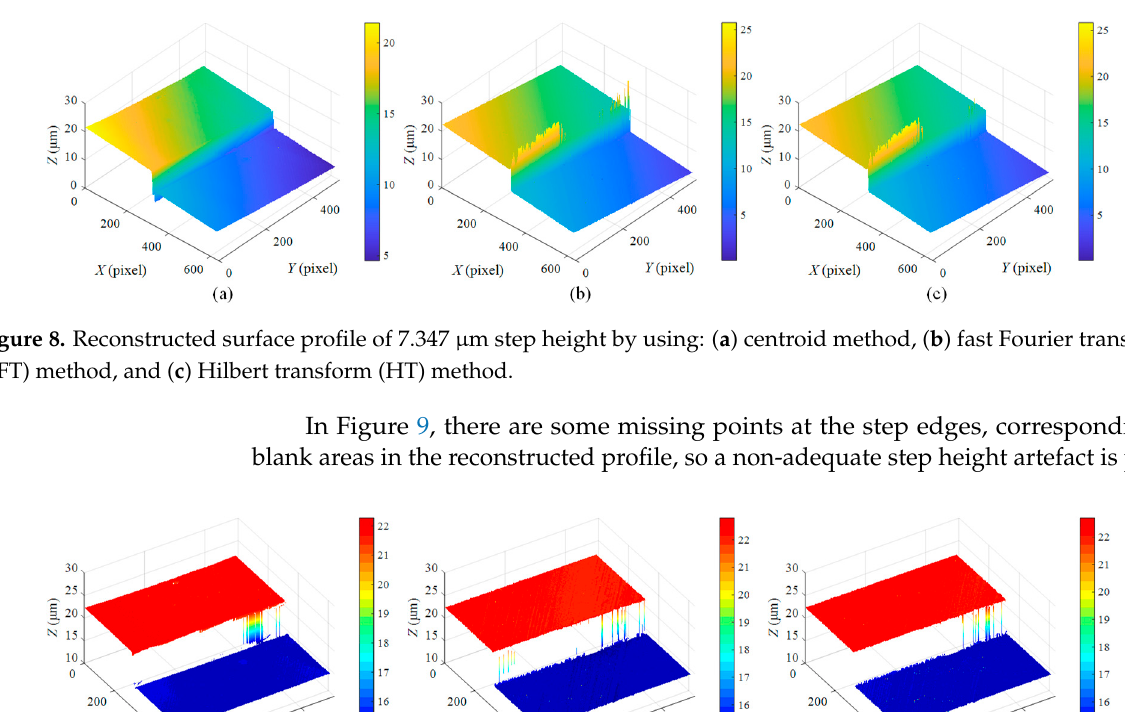
Figure 7. Experimental setup of step height measurements.